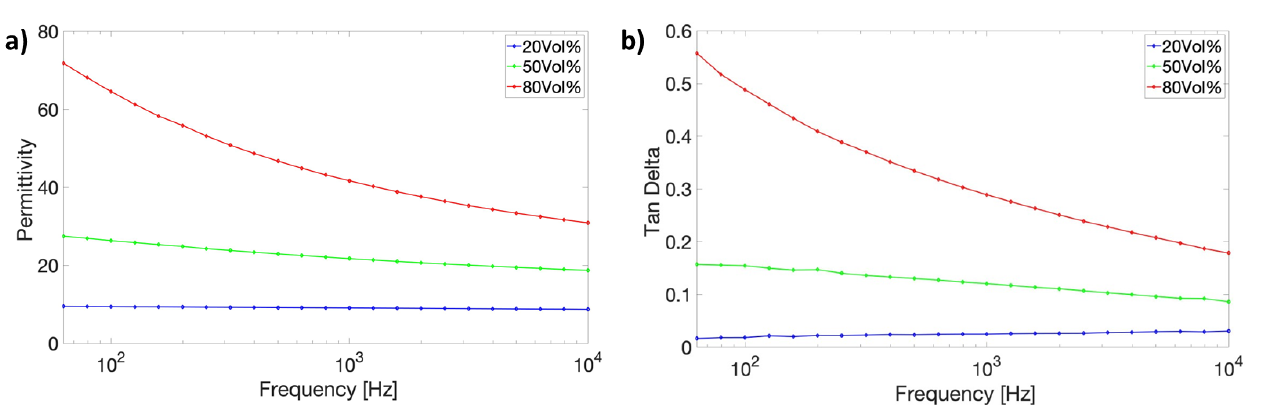
Figure 6 . Frequency dependence of ( a ) permittivity and ( b ) dielectric loss of different vol% ZnO varistor-filled composites at room temperature.